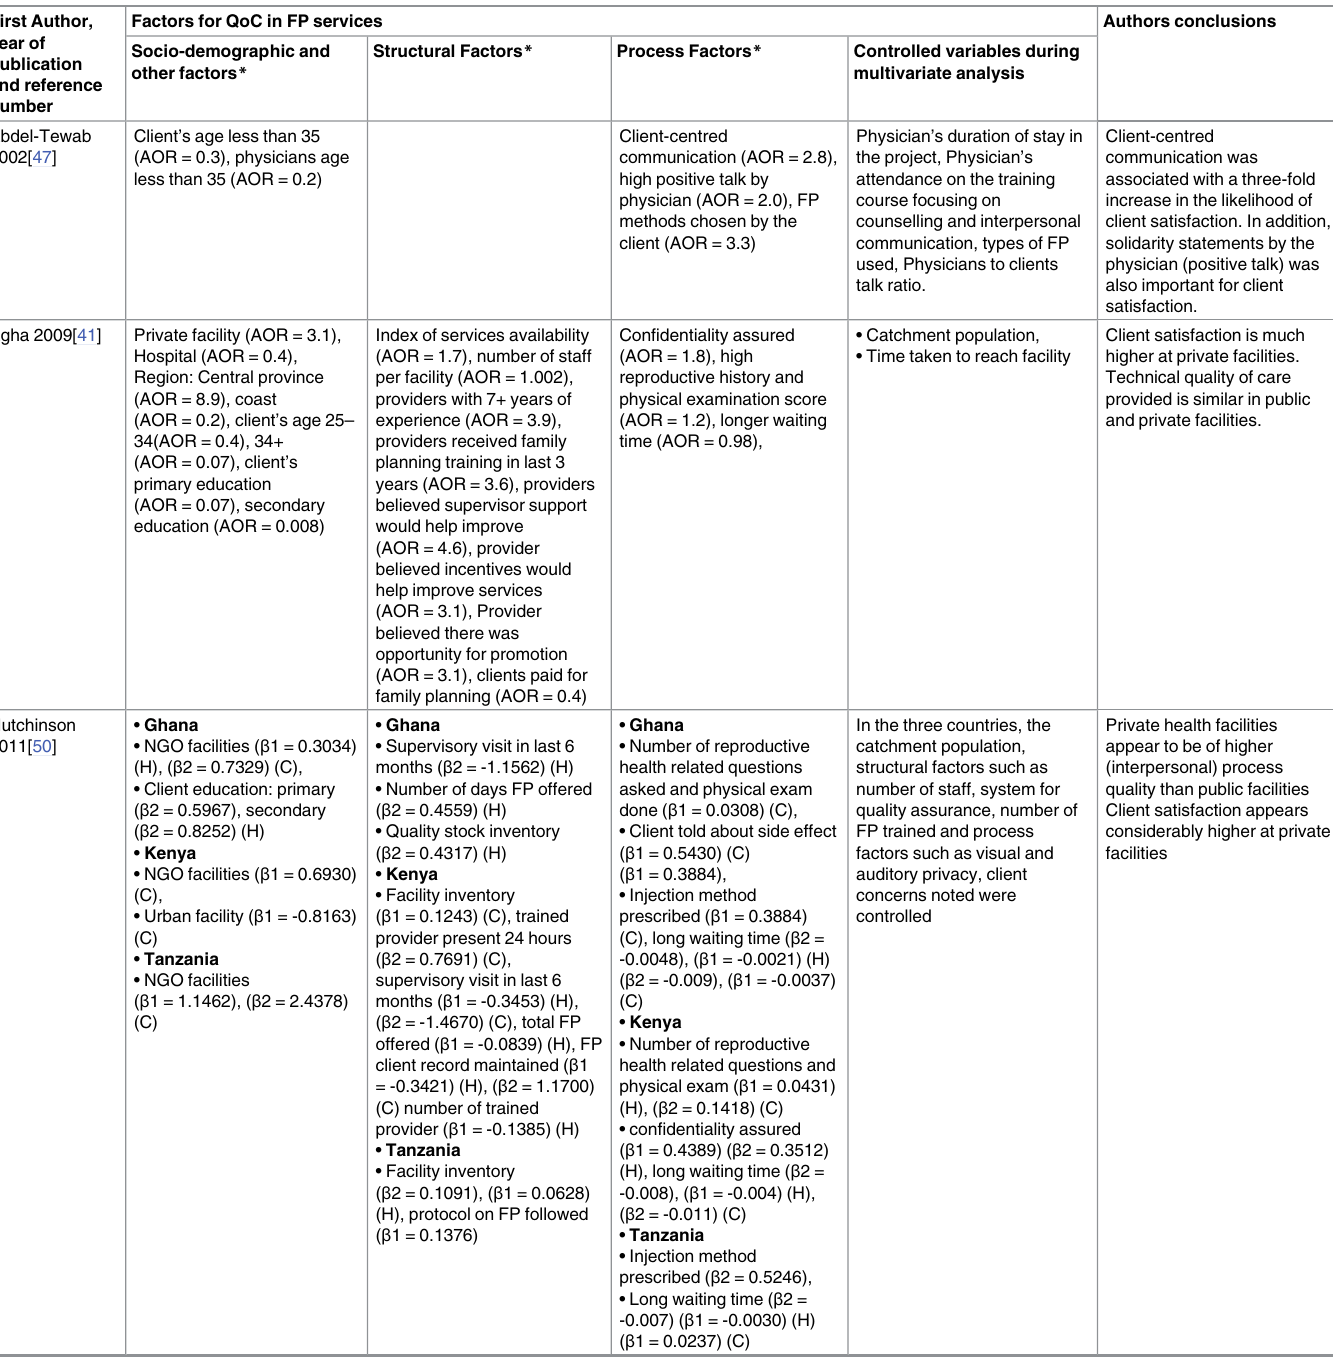
Table 3. Summary of the statistically significant factors affecting quality of care in family planning servicesin